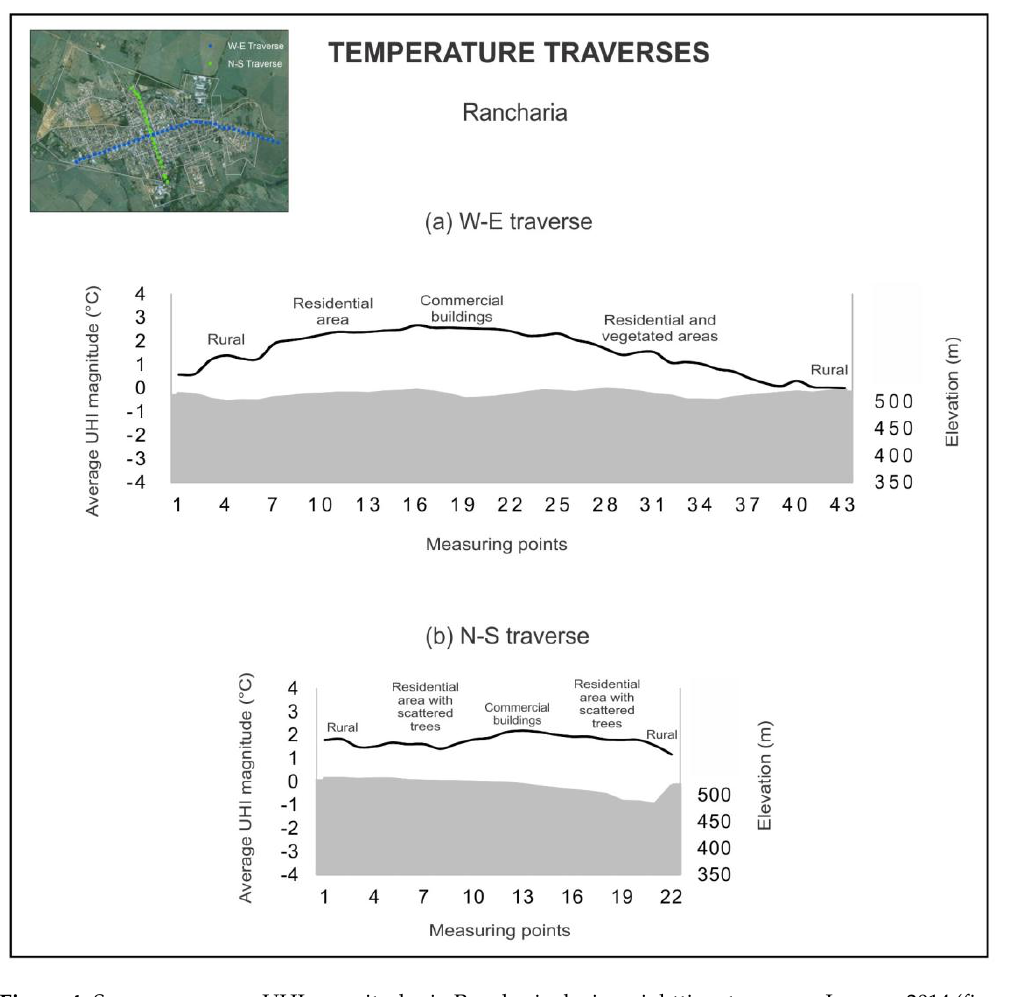
Figure 4. Summer average UHI magnitudes in Rancharia during nighttime traverses, January 2014 (five nights): ( a ) west–east traverse; and ( b ) north–south traverse. Horizontal lines indicate the temperature profile. Surface relief is shown along the bottom axes.